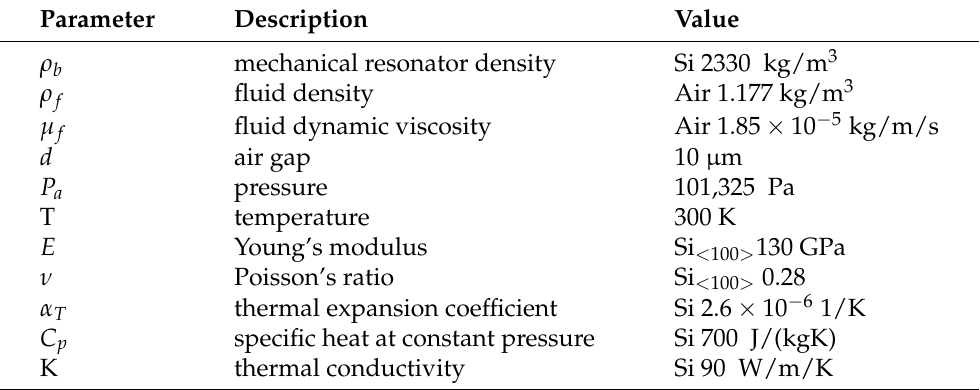
Table 3. Parameters used to describe the damping